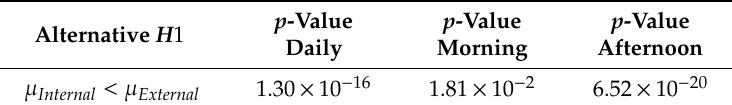
Table 4. p -values for Kolmogorov–Smirnov (K–S) one-sided test comparing the empirical cumulative distribution functions of e ff ective cloud cover ( C ef f ) in the wet (internal) and dry (external) areas of the reservoir. Null hypothesis, H 0 : µ Internal = µ External , where µ denotes the mean value of the distribution from which samples were drawn.